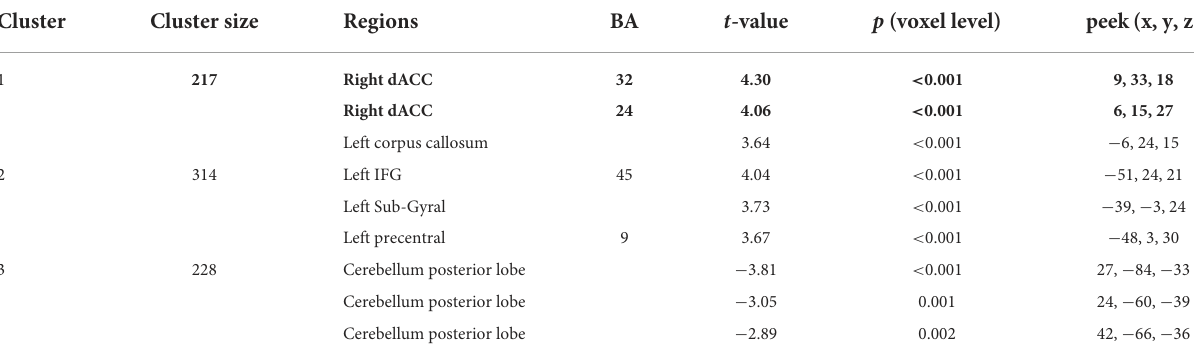
TABLE 1 The relationships between SES and spontaneous activation of social brain regions identified by whole-brain analysis (GRF-corrected p < 0.005 in voxel level with p < 0.05 in cluster level). Cluster Cluster size Regions BA t -value p (voxel